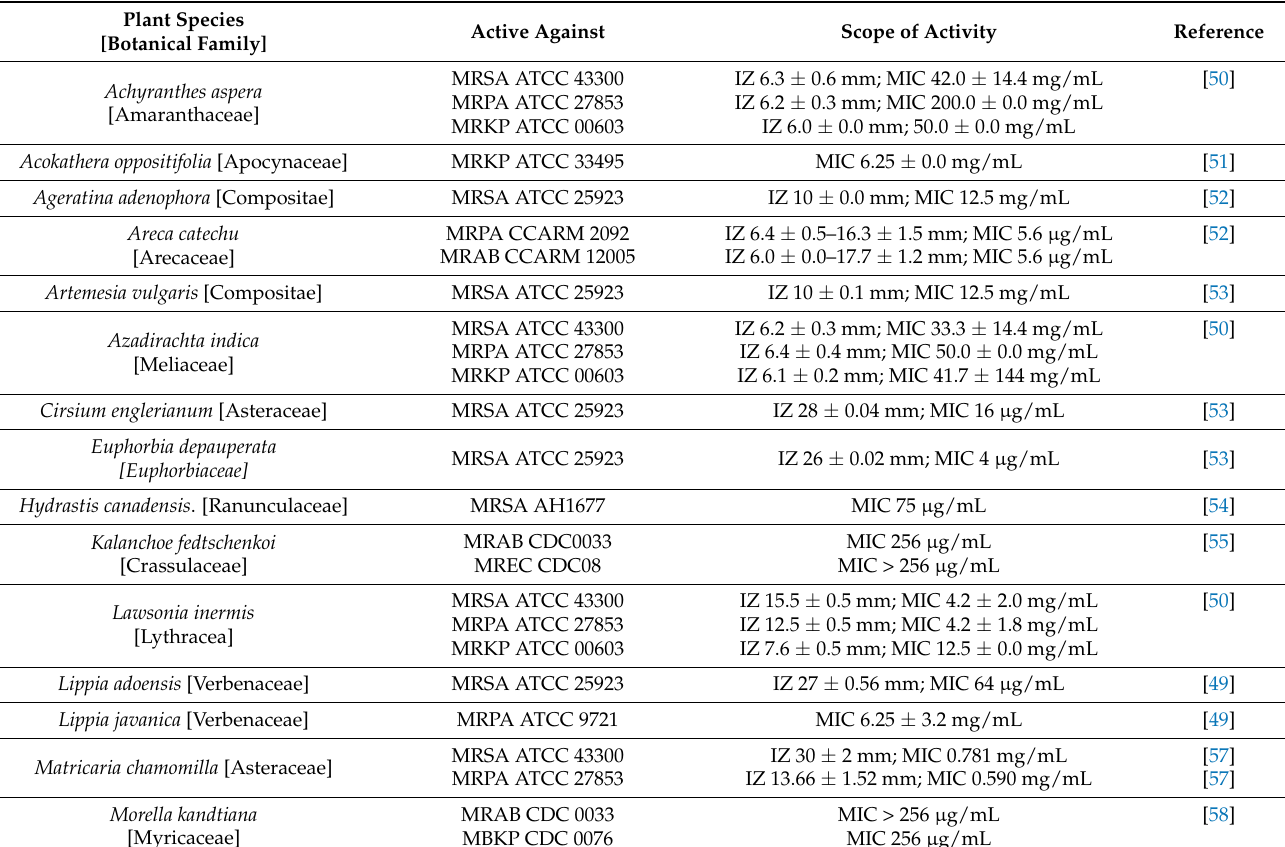
Table 1. Scope of the activity of some plants against resistant